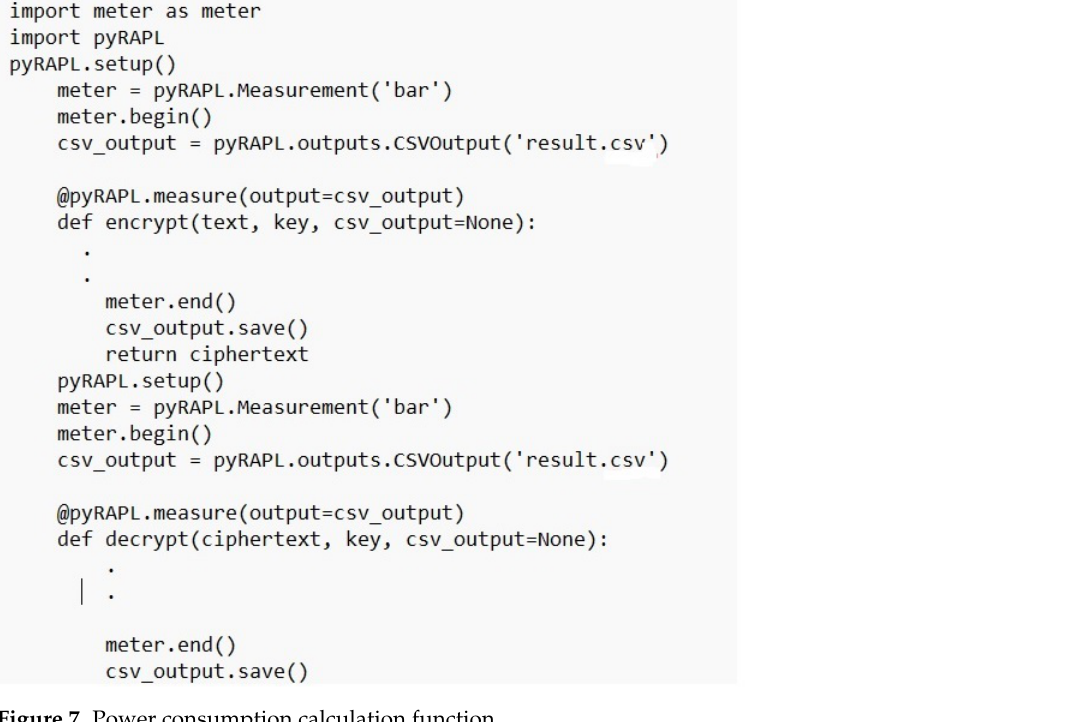
Figure 7. Power consumption calculation function.